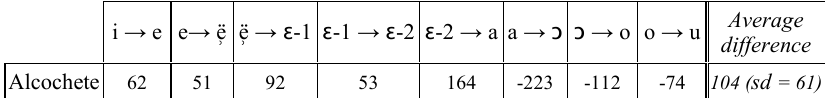
Table VI-II. F1 differences between